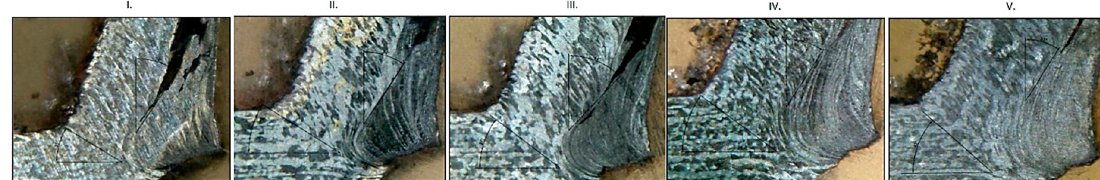
Figure 18. Successive chip roots (magnified 200×) of carbon steel EN 16MnCr5 steel for orthogonal cutting with the parameters v c = 15 m·min − 1 , a p = 0.4 mm, γ = 8°, λ s = 0°.